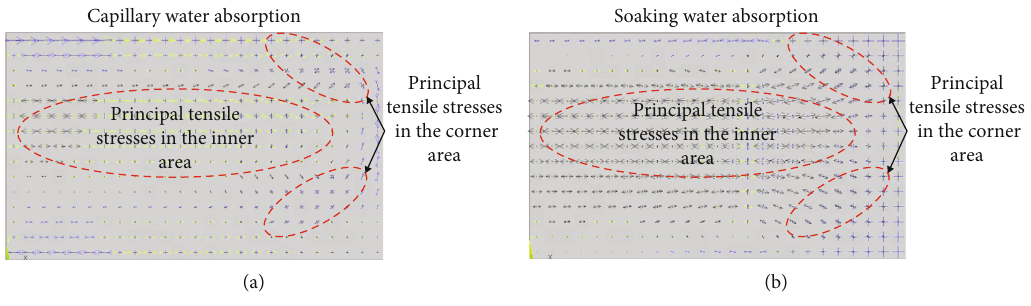
Figure 20: Principal stress vector diagram of XOY